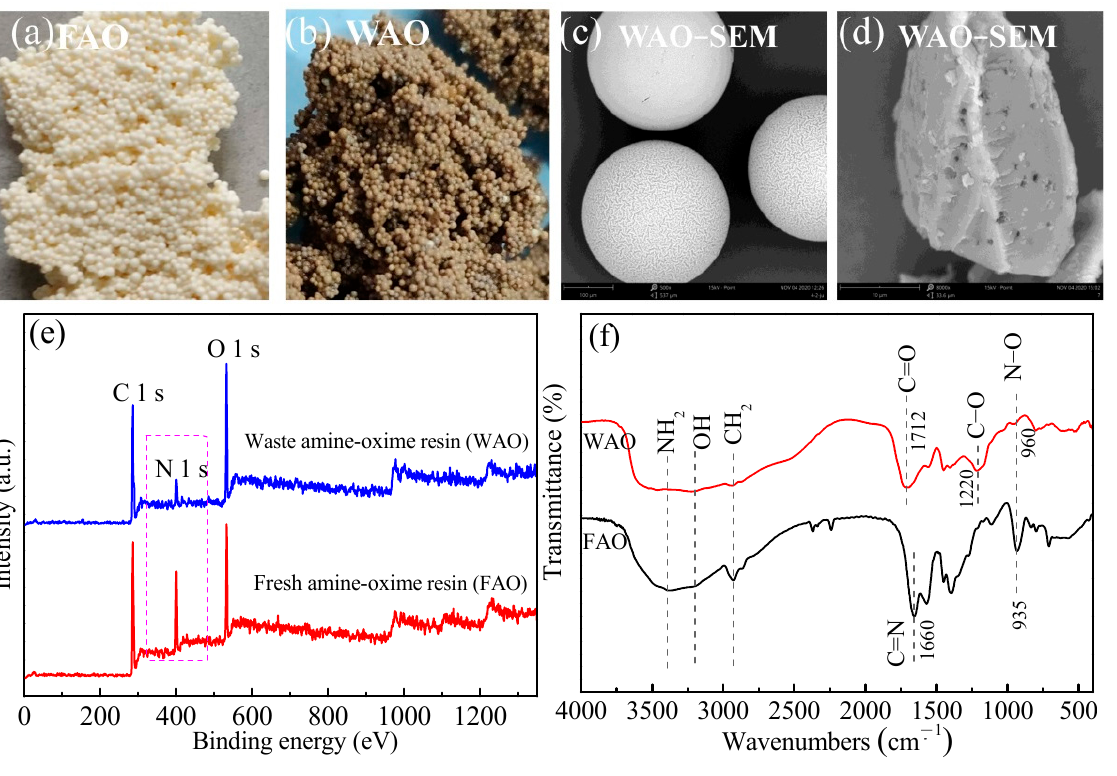
Figure 1. The structural features and elements of fresh and waste amine oxime resin: ( a ) fresh amine-oxime resin (FAO), ( b ) waste amine-oxime resin (WAO), ( c , d ) SEM of WAO, ( e ) XPS of WAO and FAO, ( f ) FT-IR of WAO and FAO. WAO’s micropore and mesopore structures were almost completely blocked when the BET and BJH models were used to analyze the specific surface area and pore volume. There- fore, WAO’s pore sizes were measured by Mercury Porosimeter (Micrometric Autopore 9620, Sarasota, Florida, USA), as shown in Figure 2a.